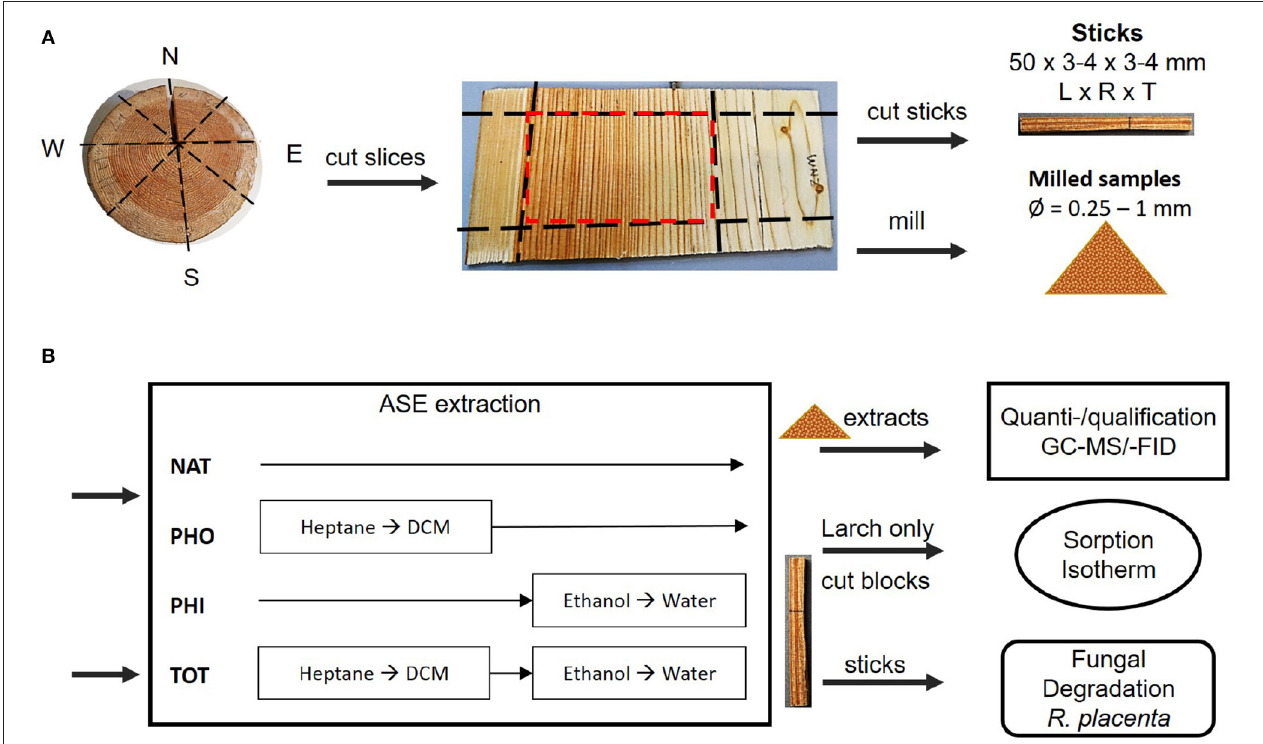
FIGURE 1 | (A) Preparation of wooden sticks, exemplified with Larch. The frozen wood disk was cut radially into slices. The mature heartwood (marked in red) was selected and one part was cut into sticks with dimensions 50 × 3–4 × 3–4 mm [longitudinal × radial × tangential]. The other part was milled. (B) Sticks and milled samples were extracted with different solvents according to the scheme. The extracts from the milled samples were quantified and identified using GC-MS/-FID. Some larch sticks were made into blocks and used for determination of the sorption isotherm. All extracted and native sticks of both species were subjected to brown-rot degradation. NAT, native; PHO, hydrophobic; PHI, hydrophilic; TOT, total; DCM, dichloromethane.